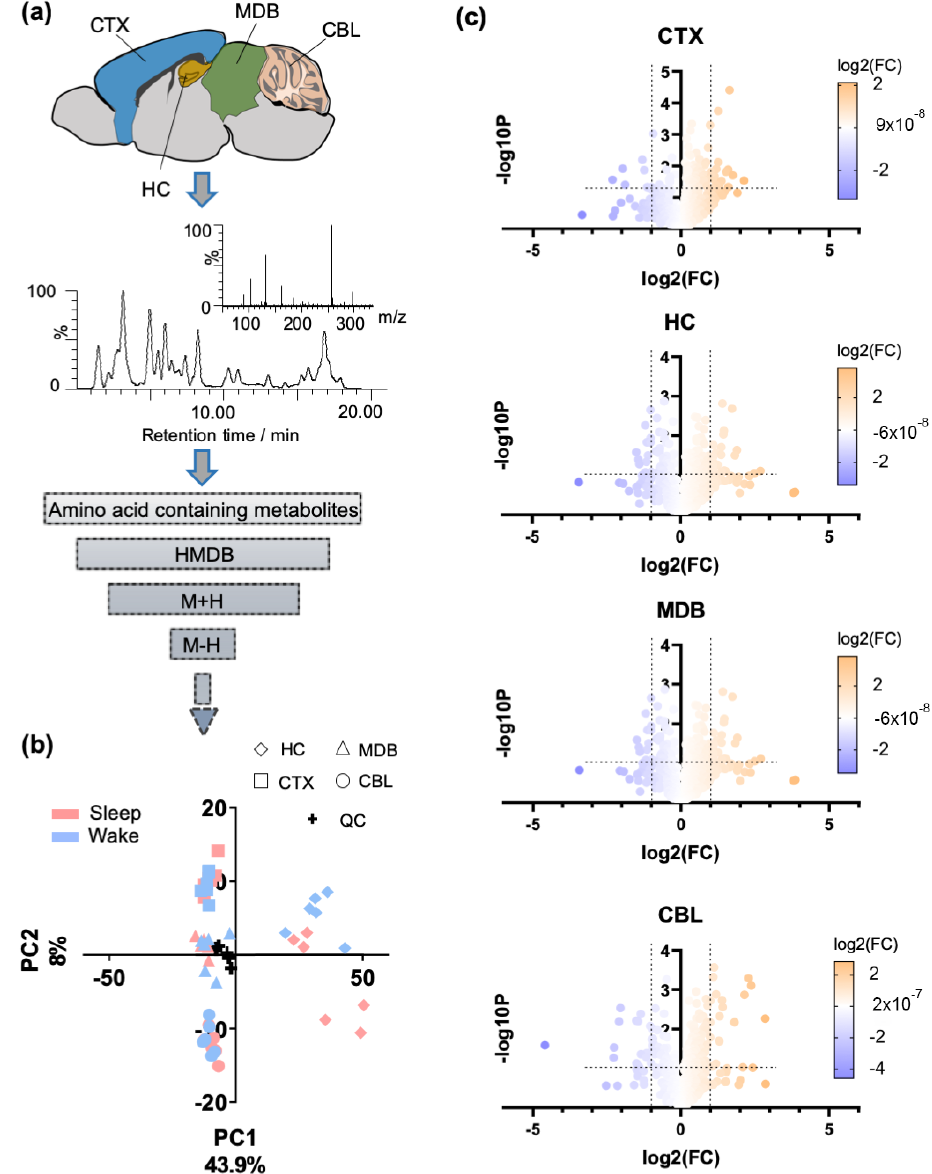
Figure 1. Overview of the metabolomics analysis of brain regions selective for amino acids and modifications. ( a ) UPLC-MS/MS-based metabolomics was applied for the analysis of amino acid analogues in four distinct brain regions in positive and negative ionization mode. The investigated brain regions are illustrated in a sagittal mouse brain tissue section. Brain tissue samples were collected from animals in sleep and wake state (N = 6 per group). ( b ) Principal component analysis on the different mouse brain regions is based on amino acid-containing metabolites (features) (N = 6 per group). ( c ) Volcano plots of the included features per brain region in both positive and negative ionization mode (two-tailed unpaired t -test on sleep/wake effects; p < 0.05). Significance is expressed as the negative log10 of the p value. Thresholds are defined as -log10 P > 1.30 and log2(FC) > 1. The color scale represents the log2 fold change (FC), where FC = (sleep)/(wake); CBL: cerebellum; CTX: cortex; HC: hippocampus; MDB: midbrain.